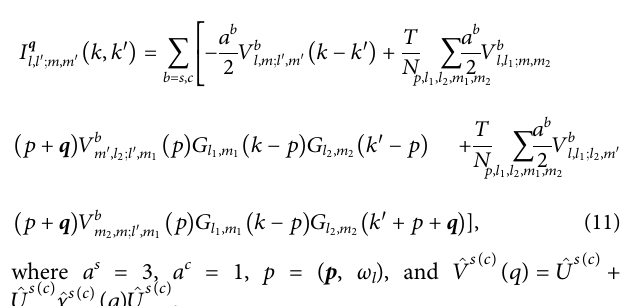
Figure 3B . The four-point vertex interaction